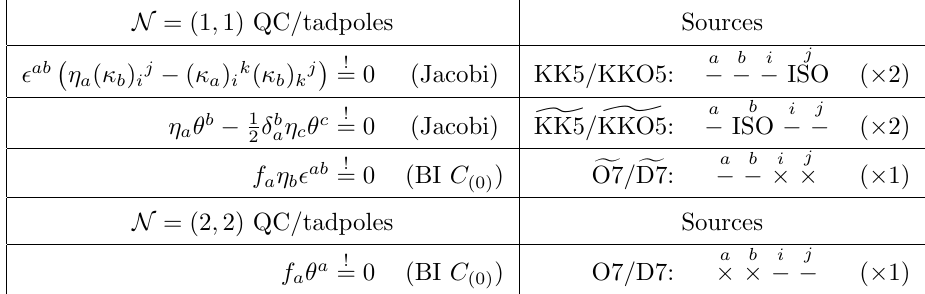
Table 20 . Non-vanishing QC (3.6), (3.8) and their higher dimensional origin for the (cid:13)ux compacti- (cid:12)cation of type IIB with O7/D7 given in table 18, where BI stands for Bianchi identities and Jacobi refers to the condition (2.10). A description of the QC as restrictions for the existence of additional local sources is given.